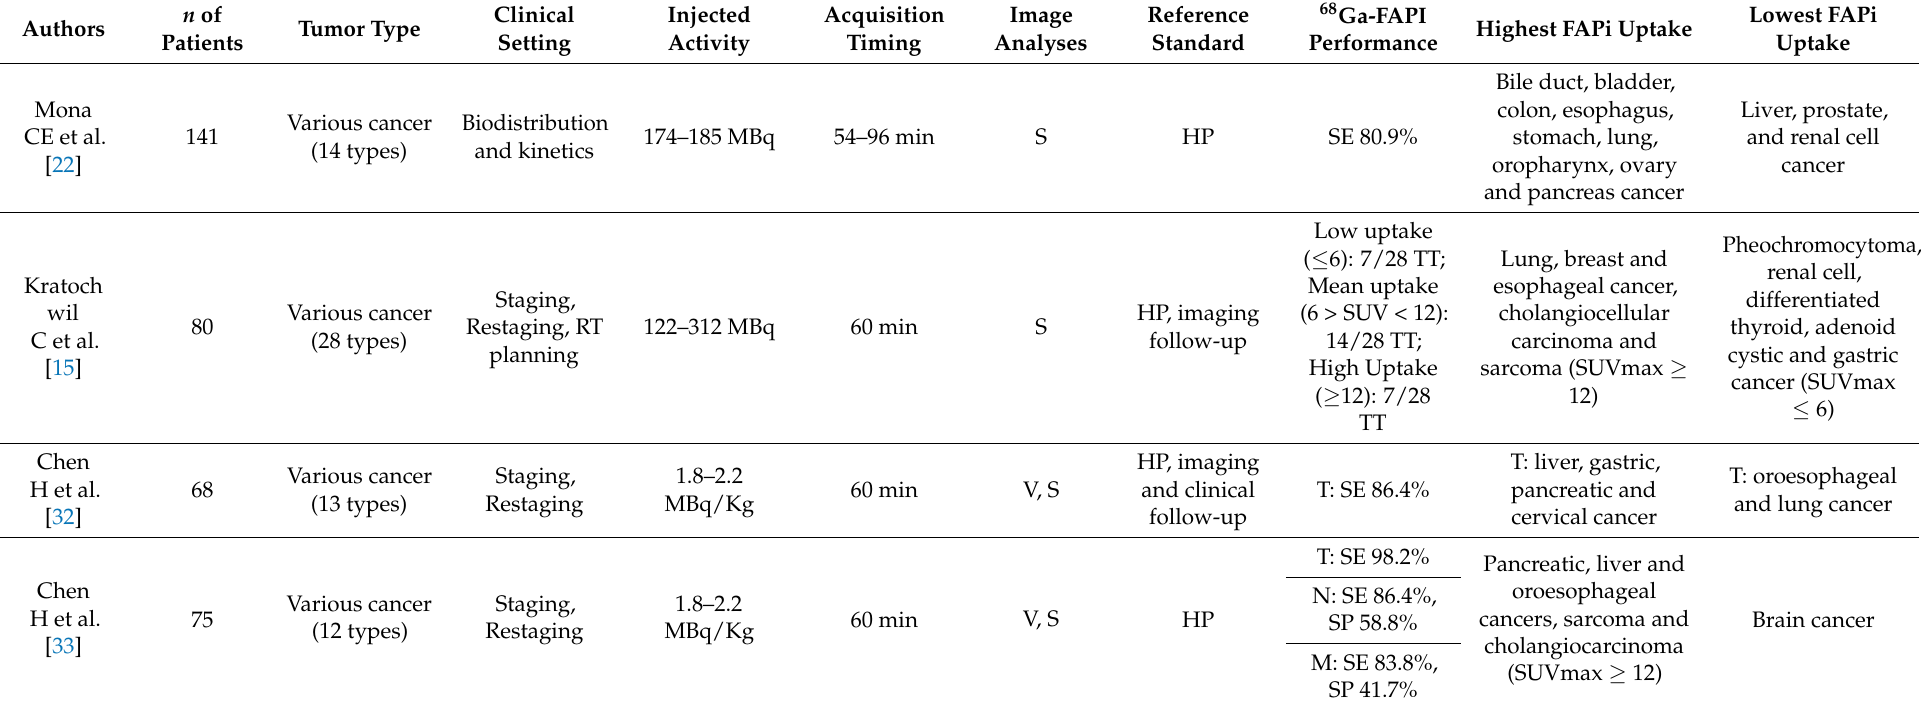
Table 1. Oncological setting: Pan-tumoral